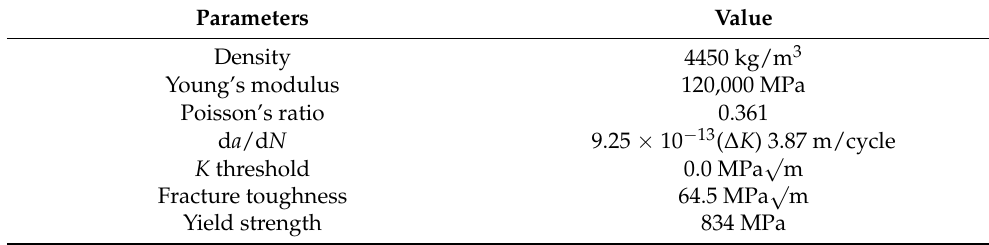
Table 2. The material parameters of Ti6Al4V.